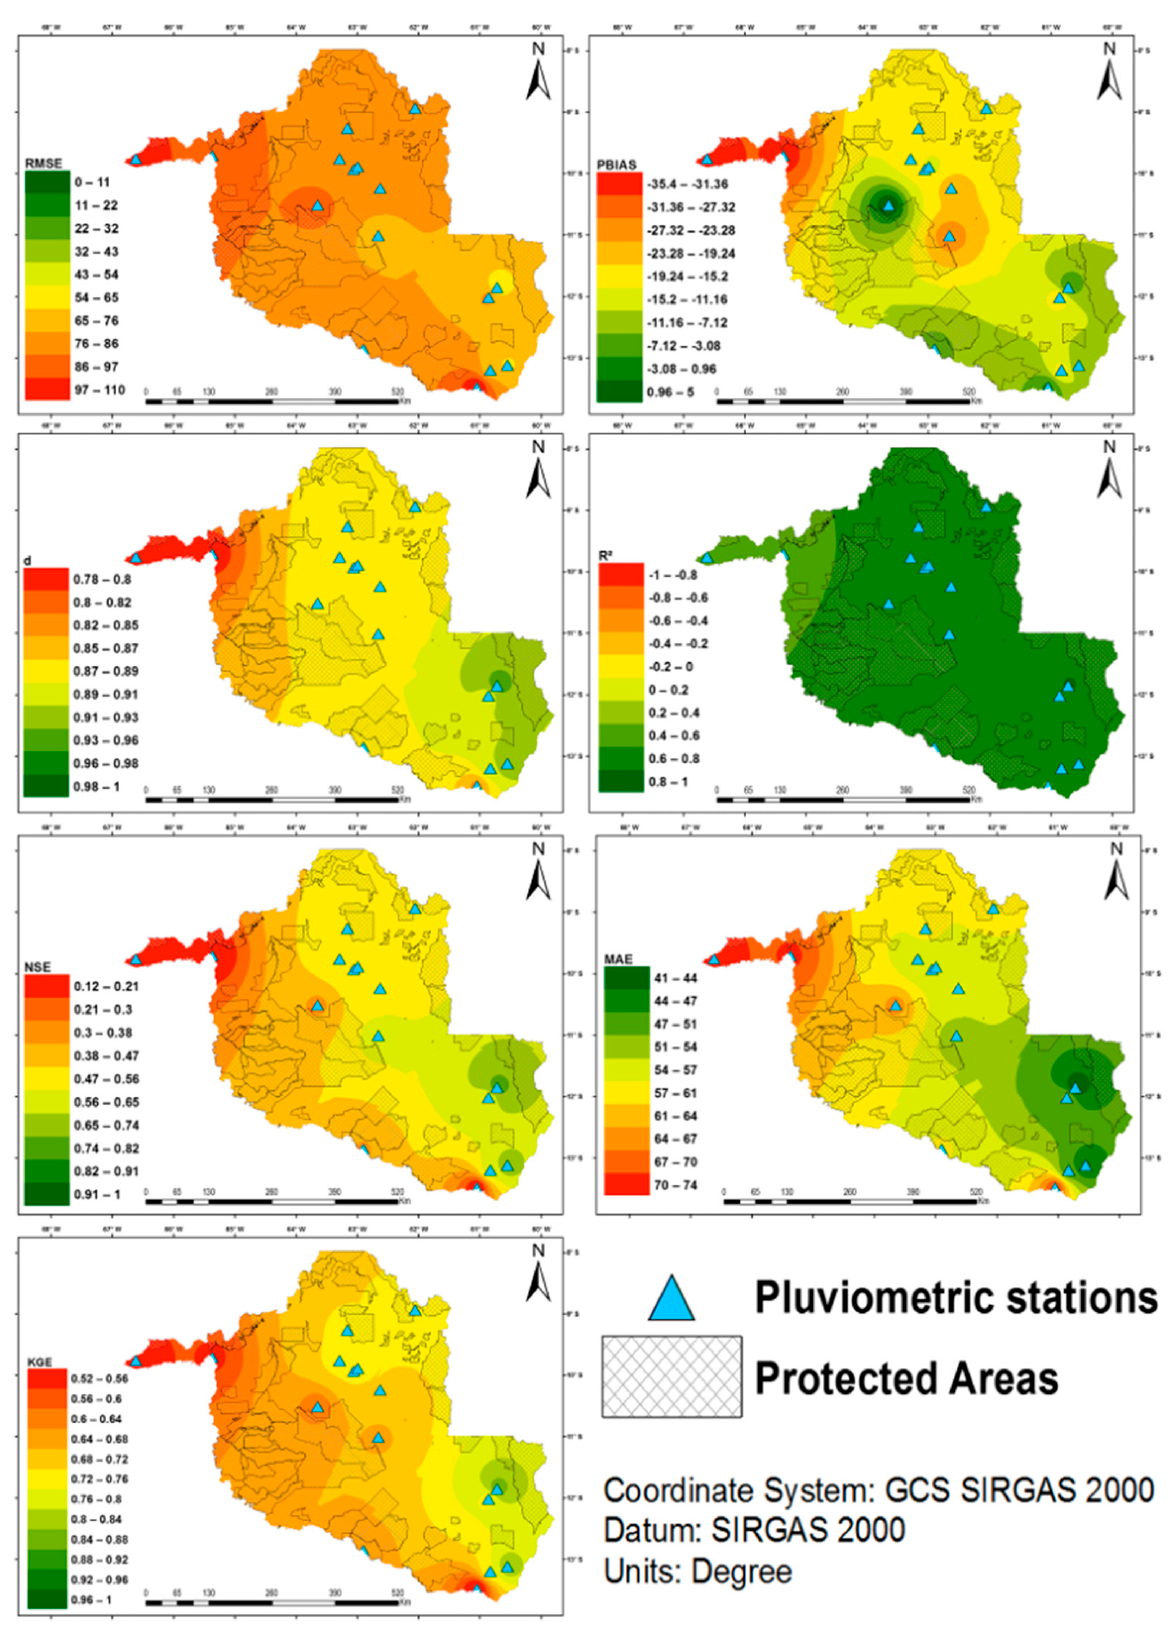
Figure 3. Spatialization of metrics RMSE, PBIAS, Willmott coefficient (d), R², NSE, MAE and KGE.